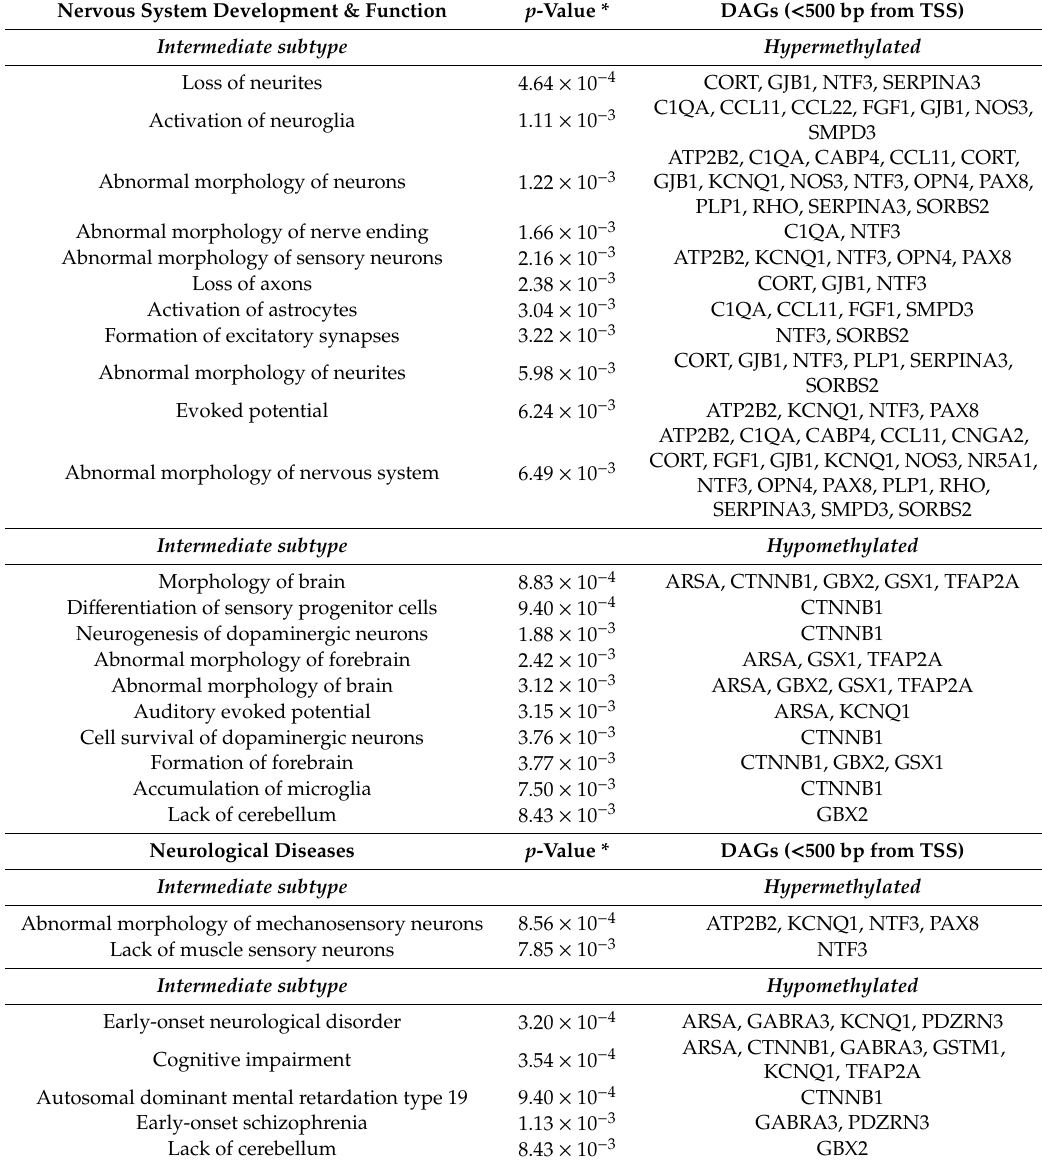
Table 4. Neurological functions and diseases enriched among DAGs implicated by CpGs within 500 bp of the TSS in the intermediate